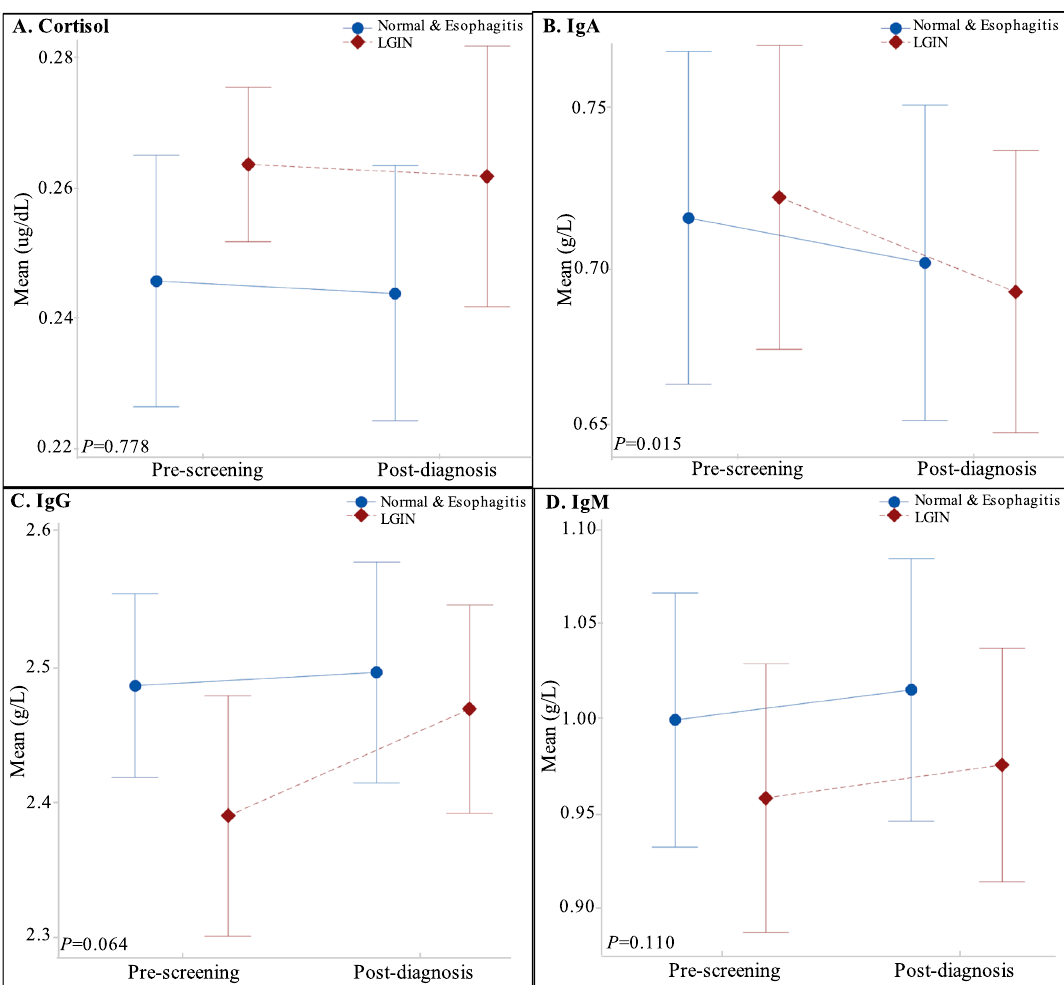
Figure 1. Comparison of cortisol and immunoglobulin levels among participates at pre-screening and post- diagnosis: by esophageal pathology grades. ( A ) Mean values of cortisol; ( B ) Mean values of IgA; ( C ) Mean values of IgG; ( D ) Mean values of